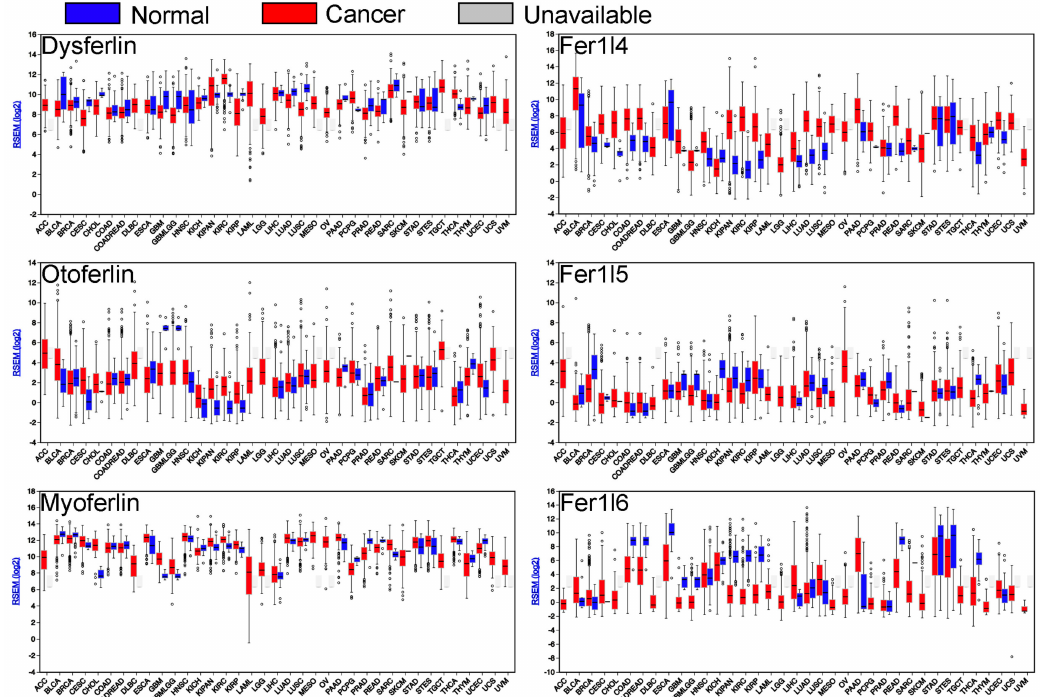
Figure 2. Ferlin gene expression in several cancers (red) and their normal counterparts (blue). Cancer tissues from adrenocortical carcinoma (ACC), bladder urothelial carcinoma (BLCA), breast invasive carcinoma (BRCA), cervical squamous cell carcinoma and endocervical adenocarcinoma (CESC), cholangiocarcinoma (CHOL), colon adenocarcinoma (COAD), colorectal adenocarcinoma (COADREAD), lymphoid neoplasm di ff use large B-cell lymphoma (DLBC), esophageal carcinoma (ESCA), glioblastoma multiforme (GBM), glioma (GBMLGG), head and neck squamous cell carcinoma (HNSC), kidney chromophobe (KICH), pan-kidney cohort (KIPAN), kidney renal clear cell carcinoma (KIRC),kidneyrenalpapillarycellcarcinoma(KIRP),acutemyeloidleukemia(LAML),brainlowergrade glioma (LGG), liver hepatocellular carcinoma (LIHC), lung adenocarcinoma (LUAD), lung squamous cell carcinoma (LUBC), mesothelioma (MESO), ovarian serous cystadenocarcinoma (OV), pancreatic adenocarcinoma (PAAD), pheochromocytoma and paraganglioma (PCPG), prostate adenocarcinoma (PRAD), rectum adenocarcinoma (READ), sarcoma (SARC), skin cutaneous melanoma (SKCM), stomach adenocarcinoma (STAD), stomach and esophageal carcinoma (STES), testicular germ cell tumours (TGCT), thyroid carcinoma (THCA), thymoma (THYM), uterine corpus endometrial carcinoma (UCEC), uterine carcinosarcoma (UCS), uveal melanoma